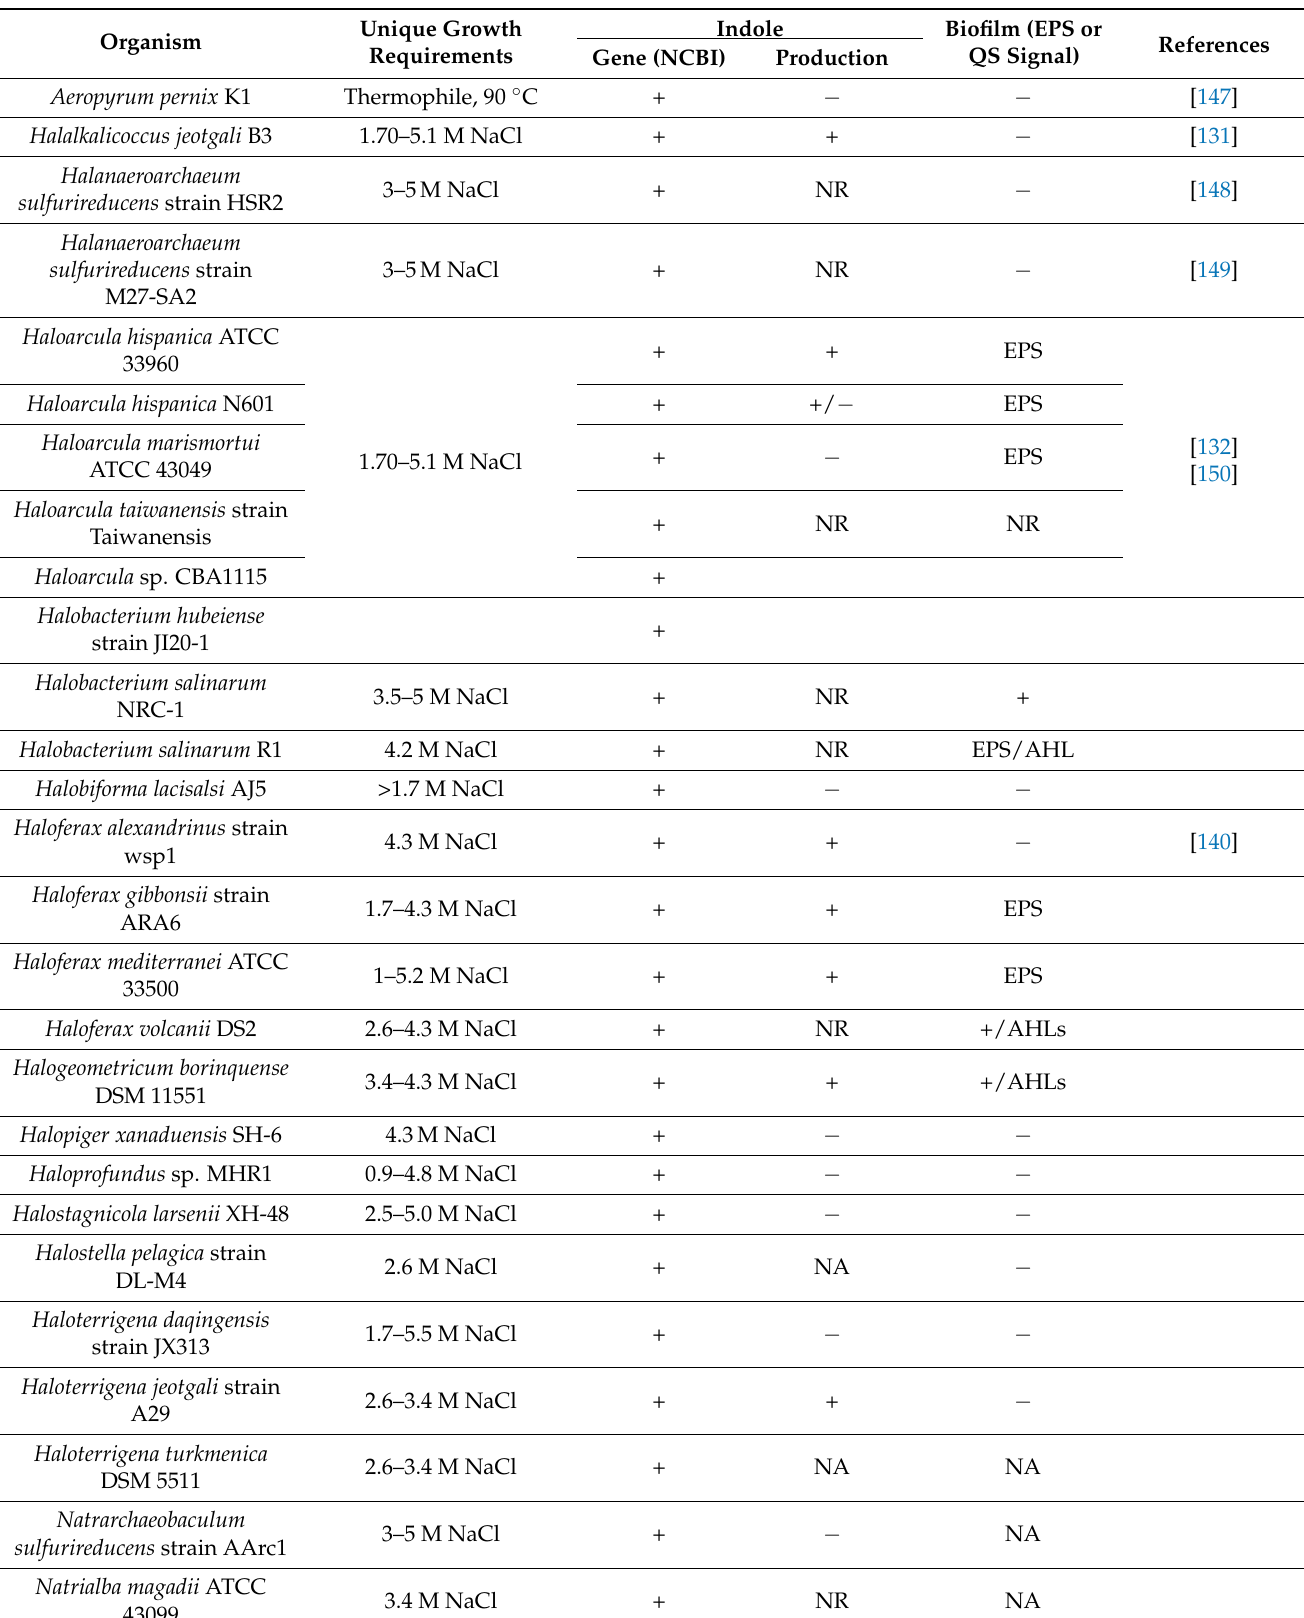
Table 2. List of archaea possessing the tnaA gene and/or indole producing